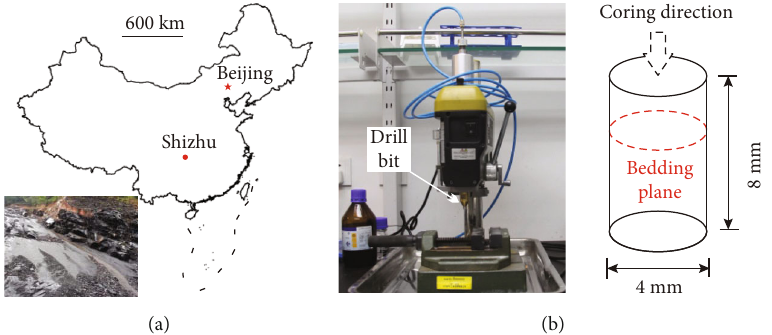
Figure 1: The location of sampling (a), the hand-operated electric drill and the diagram of a specimen (b).